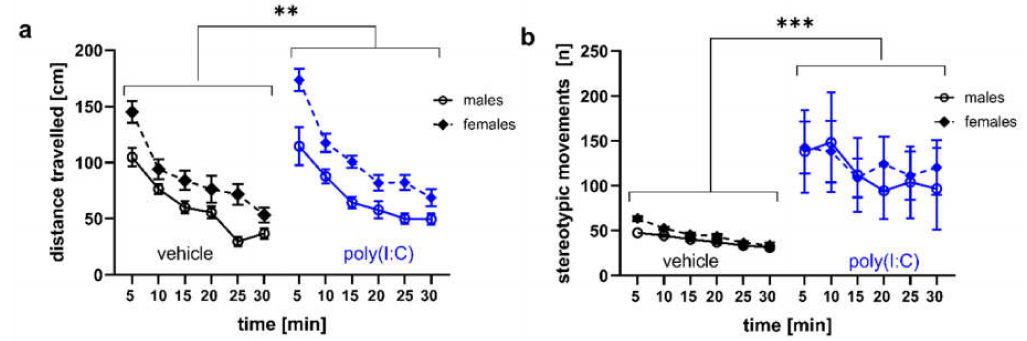
Figure 5. Poly(I:C) exposure elevated locomotor activity and stereotypic-like movements. Data are presented as a mean ± SEM of the distance traveled ( a ) and stereotypic-like movements ( b ) assessed during a 30-min test session. Symbols: ** p < 0.01, *** p < 0.001: a significant overall difference between vehicle- and poly(I:C)-exposed animals (Tukey HSD post hoc test following a significant treatment